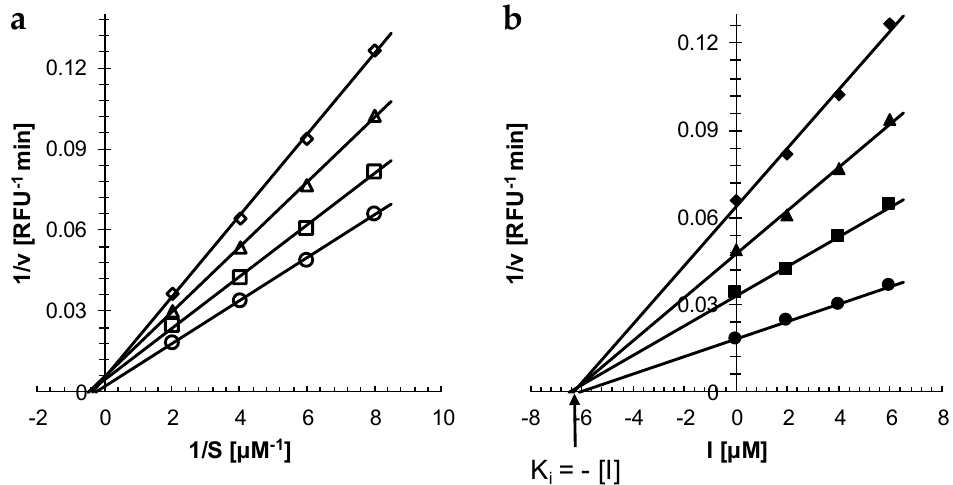
Figure 2. Determination of inhibitor type and constant of curcumin for rhodesain. Purified rhodesain (14 ng/mL = 0.4 nM) was incubated with varying concentrations of Z ‐ FR ‐ AMC (0.125, 0.167, 0.25 and 0.5 μ M) and curcumin (0, 2, 4 and 6 μ M) in 100 mM citrate, pH 5.0, 2 mM dithiothreitol, 2% DMSO. ( a ) Lineweaver ‐ Burk plot. The concentrations of curcumin were 0 μ M (open circles), 2 μ M (open squares), 4 μ M (open triangles) and 6 μ M (open diamonds). ( b ) Dixon plot for determining the inhibitor constant K i . The concentrations of the substrate Z ‐ FA ‐ AMC were 0.5 μ M (closed circles), 0.25 μ M (closed squares), 0.167 μ M (closed triangles) and 0.125 μ M (closed diamonds). A representative experiment out of three is shown.